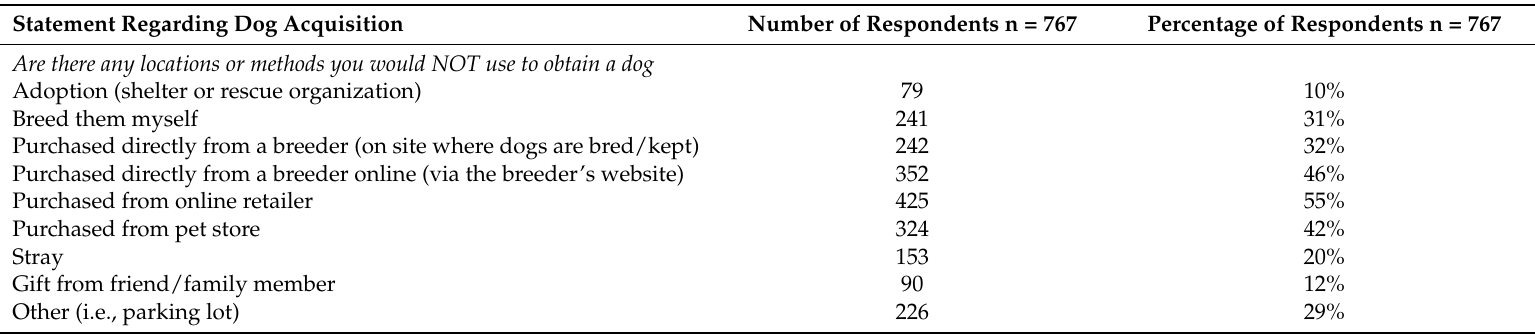
Table 2. Percentage of respondents who selected each method they would not use to obtain a dog. Multiple selections were permitted (n = 767) (number of selections = 2132). Statement Regarding Dog Acquisition